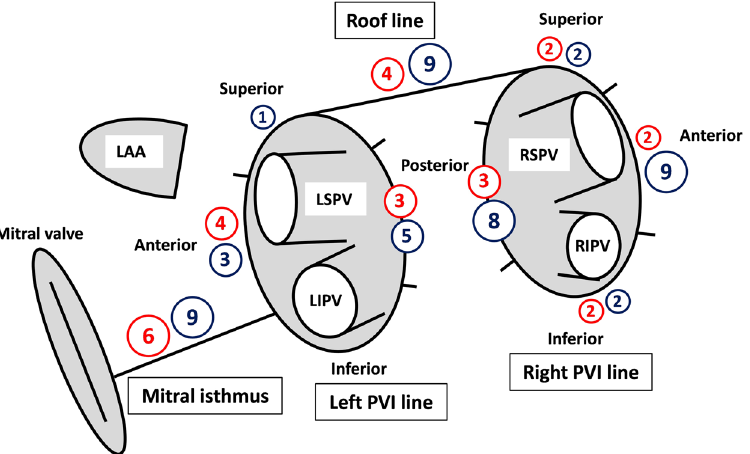
Figure 1. Schematic illustration of the pre-specified ablation lesion set and the distribution of 3-month conduction gaps. The encircling PVI lesions were arbitrarily divided in 4 anatomical segments: superior, anterior, inferior and posterior. The 3-month conduction gaps in patients with and without ERAF were represented with dark blue and red circles, respectively. The absolute number of gaps in each segment was given within the circle and size of the circle roughly correlates with the number of local gaps. LAA, left atrial appendage; PVI, pulmonary vein isolation; LSPV, left superior pulmonary vein; LIPV, left inferior pulmonary vein; RSPV, right superior pulmonary vein; RIPV, right inferior pulmonary